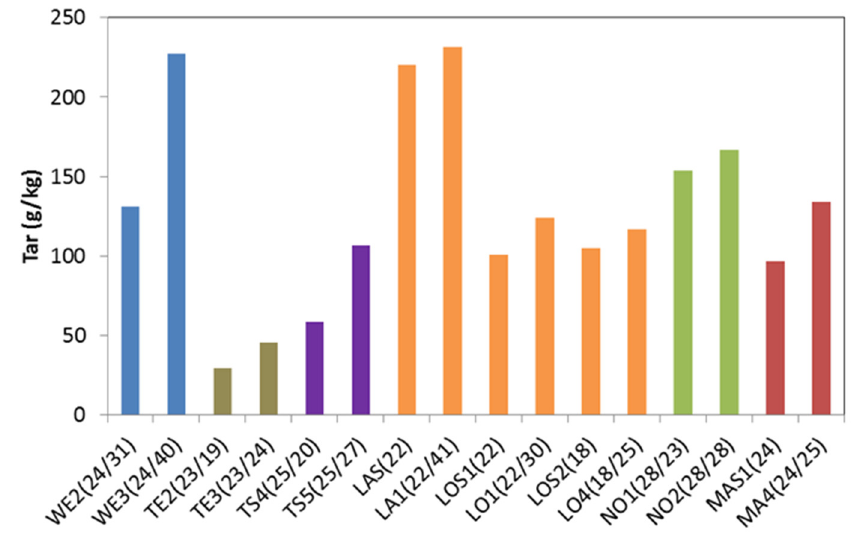
Figure 3. Yield of tar as function of the equivalence ratio ER(H 2 O).